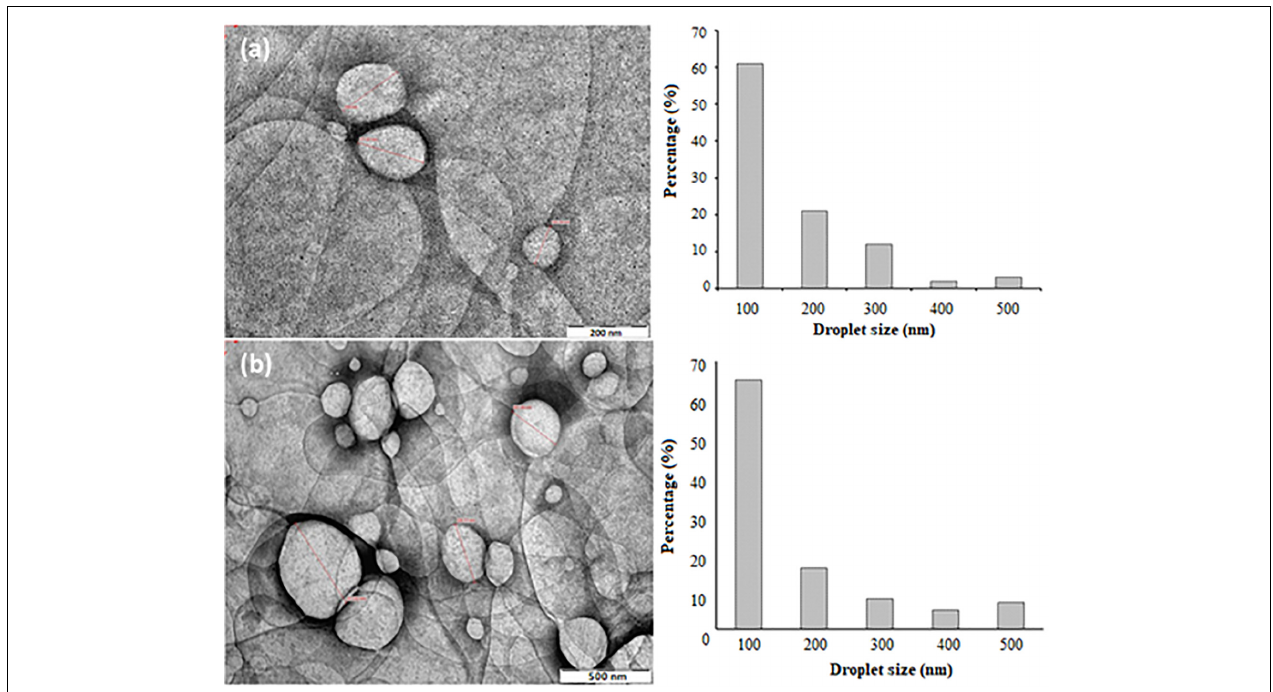
FIGURE 6 | TEM morphologies and size distributions of (a) NT 6 at 66,000 magnifications (b) NT 11 at 40,000 magnifications.